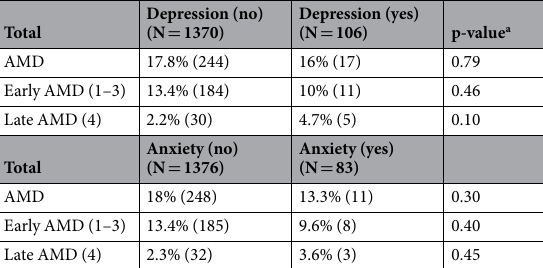
Table 6. Prevalence of depression and anxiety in a subsample with visual acuity > 0.3 logMar of the worse eye. a chi-square test Abbreviations: AMD (age-related macular degeneration).